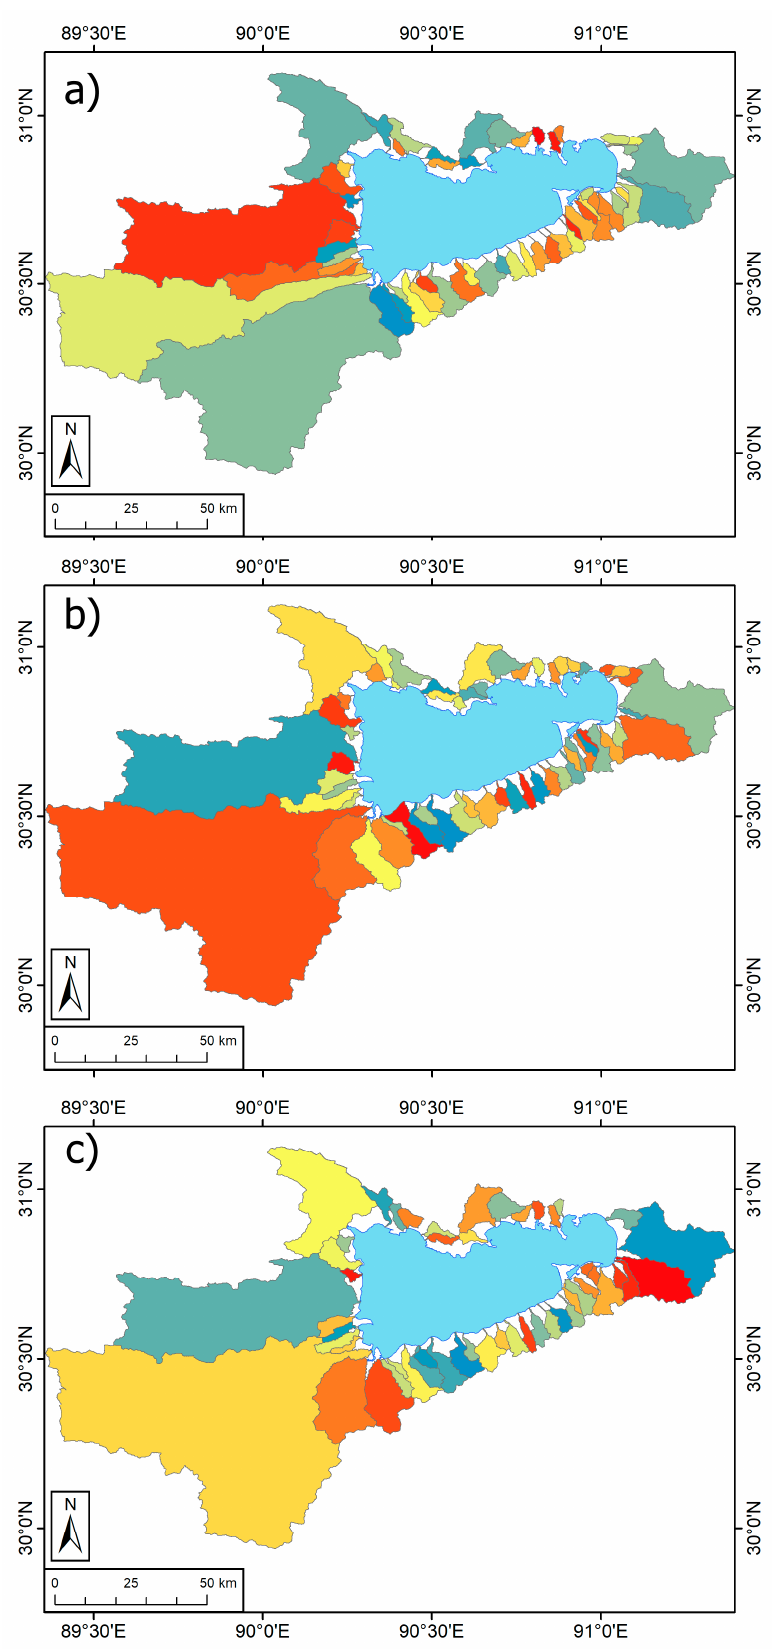
Figure A3. Subcatchment delineations of ( a ) TanDEM-X 90 m ( b ) ACE2 90 m ( c ) SRTM 90 m.